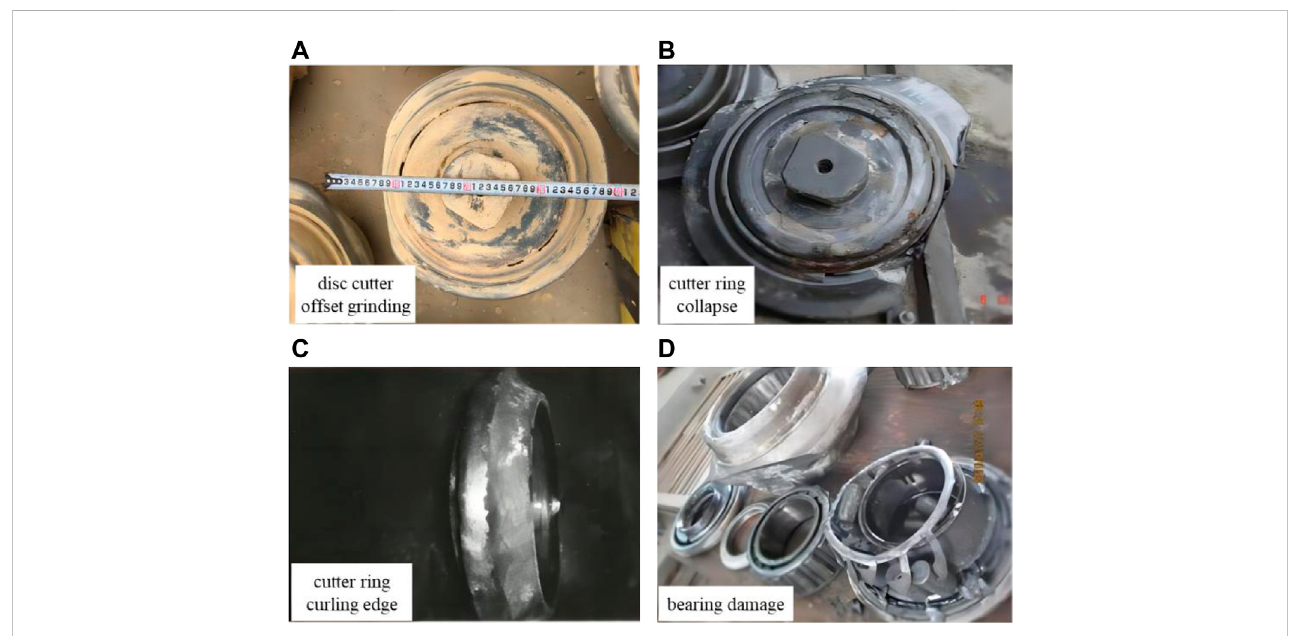
FIGURE 1 TBM disc cutter damage (A) disc cutter offset grinding (B) cutter ring collapse (C) cutter ring curling edge (D) bearing